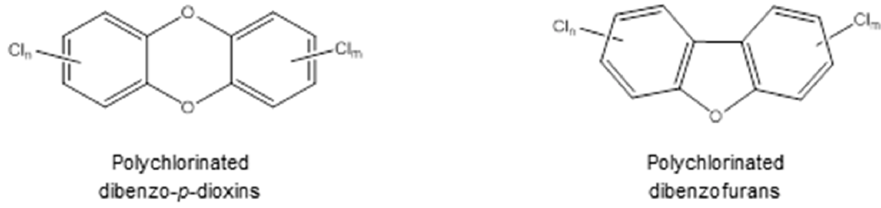
Figure 4. Chemical structure of PCDD/Fs.